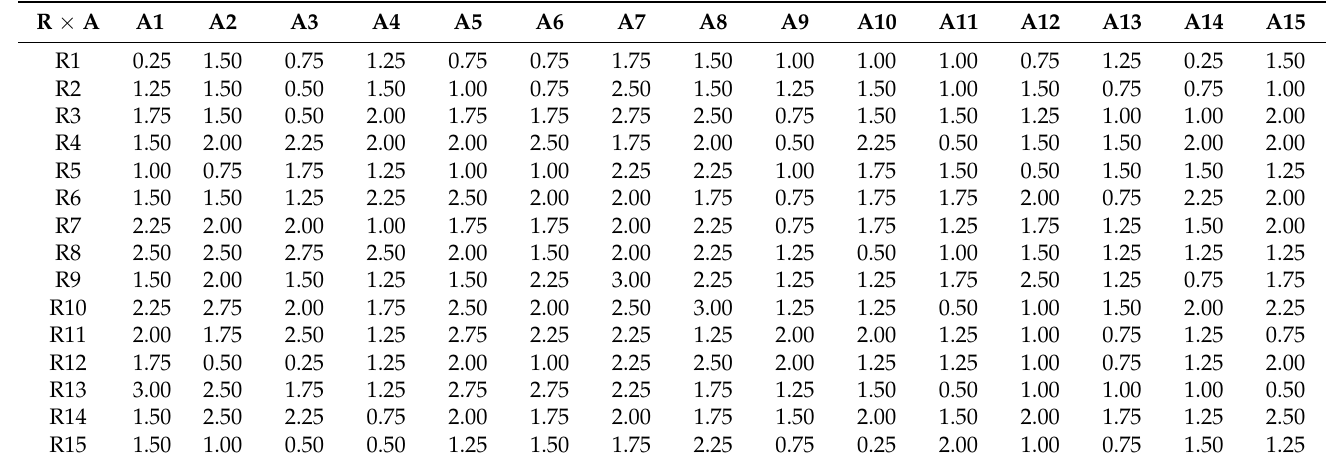
Table 7. The correlation matrix R × A of REFs and SCAIs.